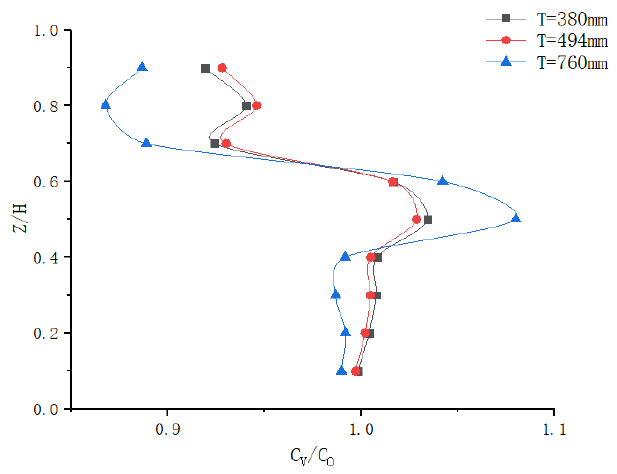
Figure 19. Verification of the optimized scale-up index at 10% v/v .